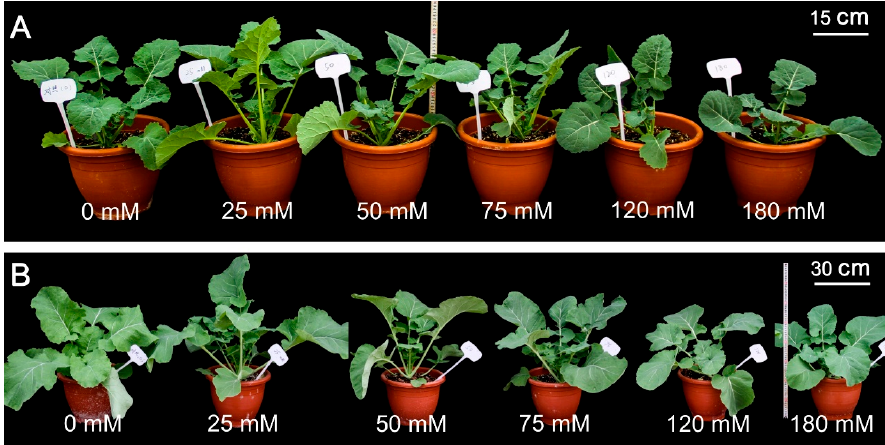
Figure 1. Effects of different salinity levels on the growth performance of two Brassica napus varieties, CH336 (semi-winter type) and Brutor (spring type), at six-leaf stage in pot cultures. ( A ). Semi-winter Table 1. E ff ects of di ff erent salinity levels on the seedling growth parameters of two Brassica napus varieties, CH336 (semi-winter type) and Brutor (spring type), in pot cultures.